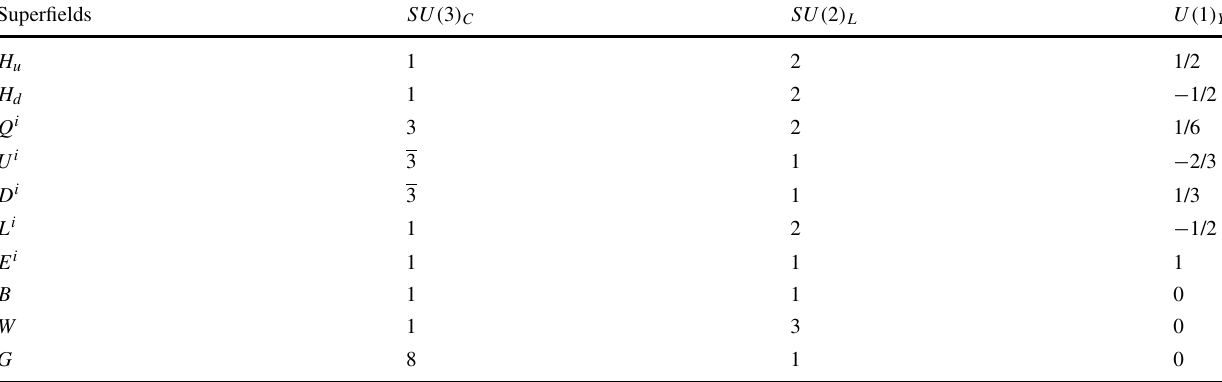
Table 19 MSSM: quantum numbers of superfields under the gauge groups. Internal symmetry indices have been suppressed. i =1,2,…, N f is the flavor index Superfields SU ( 3 ) C SU ( 2 ) L